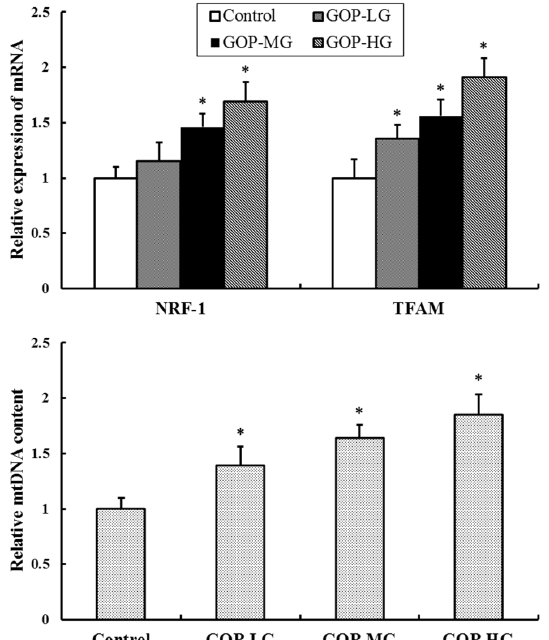
Figure 3. Effects of GOP on the RNA expression of nuclear respiratory factor 1 (NRF ‐ 1), Mitochondrial transcription factor A (TFAM) and mitochondrial DNA (mtDNA) copy number in skeletal muscles of mice by real ‐ time PCR analysis. β‐ actin mRNA levels were used as a control. Values were represented as means ± SD. * p < 0.05 versus control group. GOP ‐ LG, ginseng oligopeptides low ‐ dose group; GOP ‐